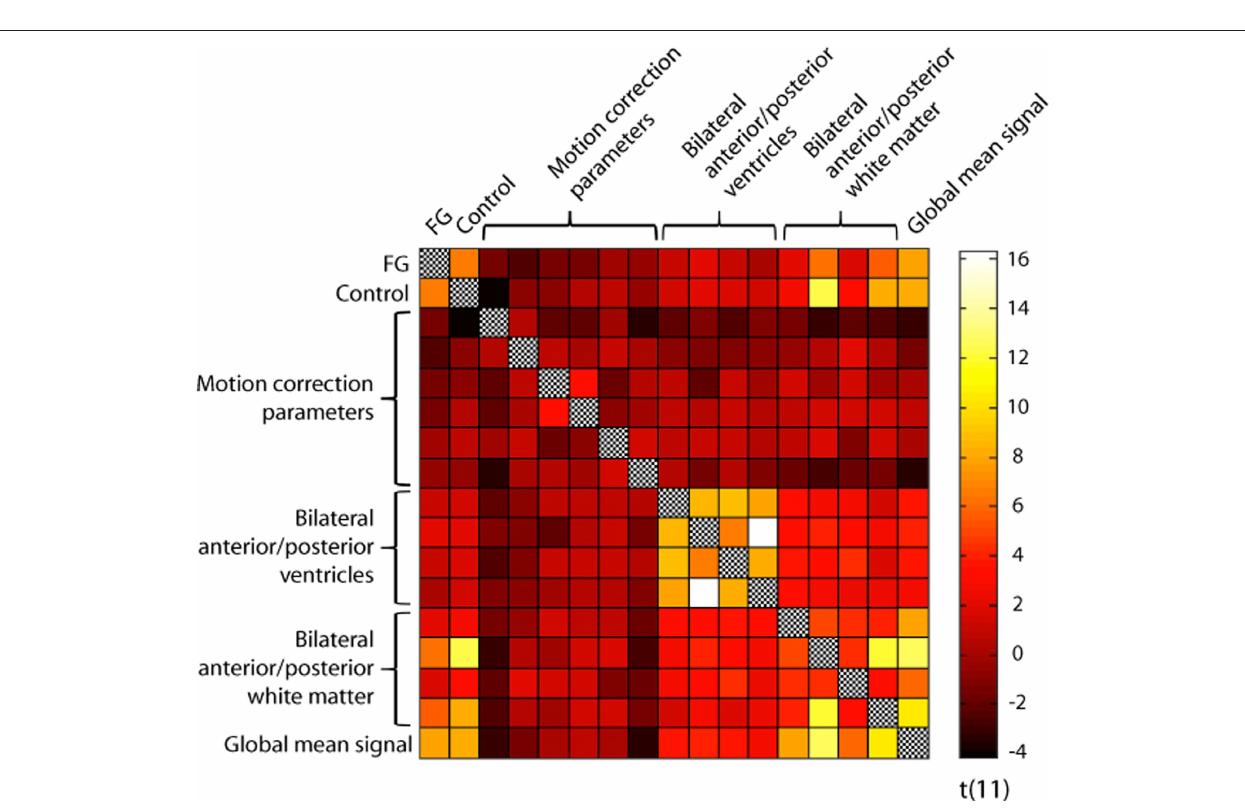
FIguRe A1 | example resting run model from experiment 1. Resting timeseries were extracted from the localized FG and control seed regions, and entered into a multiple regression model of the same resting run with several nuisance regressors of no